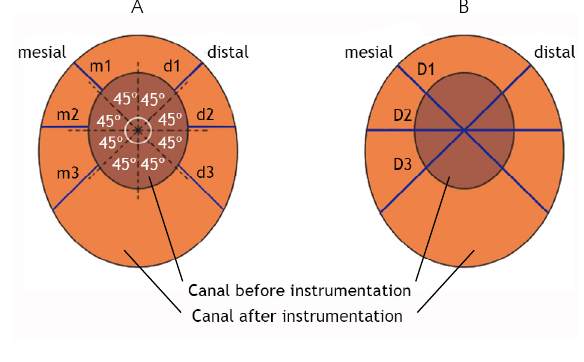
Figure 1. Schematic of the super-positioned root canals, be- fore and after instrumentation, with central axis and respective peripheral distances. (A) Difference between the distances of the distal portion d1, d2 and d3; difference between the distances of the mesial portion m1, m2 and m3. (B) Final dia- meter of the root canal after instrumentation D1, D2 and